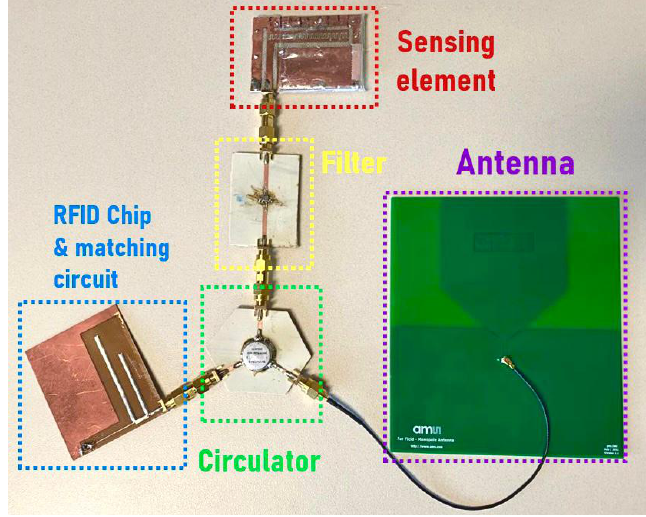
Figure 2. Three-port RFID sensing node